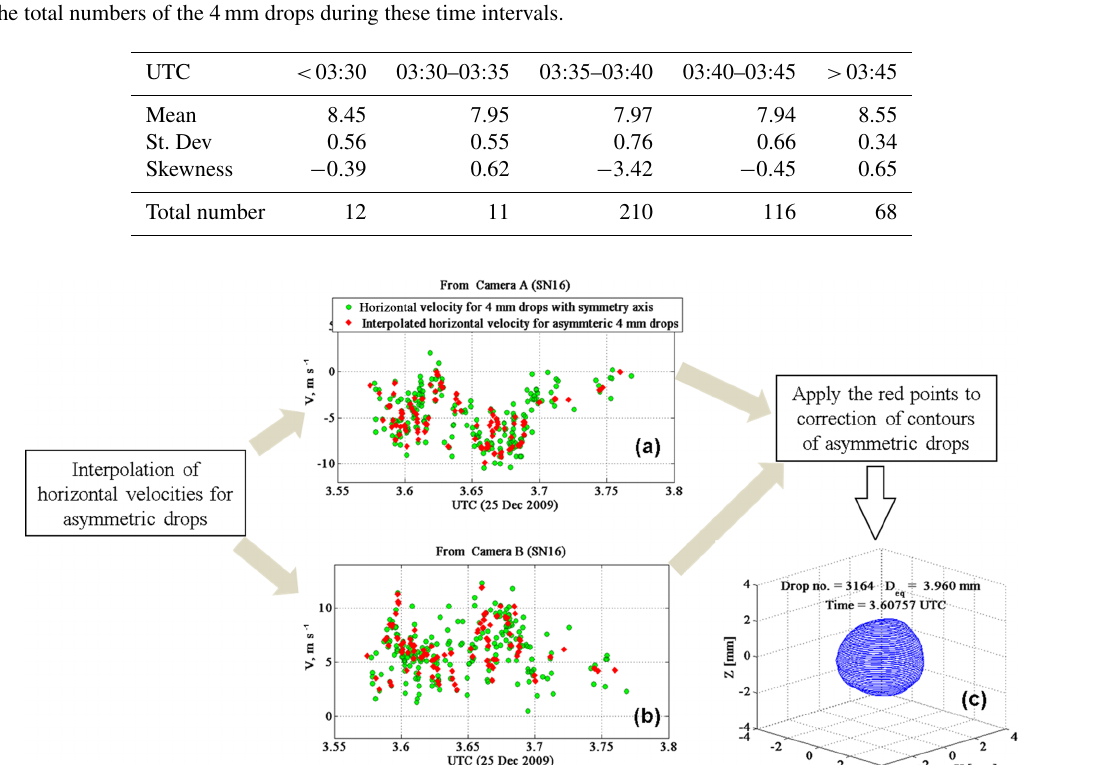
Figure 2. (a) Drop horizontal velocities of all symmetric drops (red) derived from camera A measurements and the time interpolated velocities for the asymmetric drops (green); (b) same as (a) except for camera B; (c) an example of a large asymmetric drop reconstructed from the camera A and B contoured images after correcting for the drop horizontal velocity